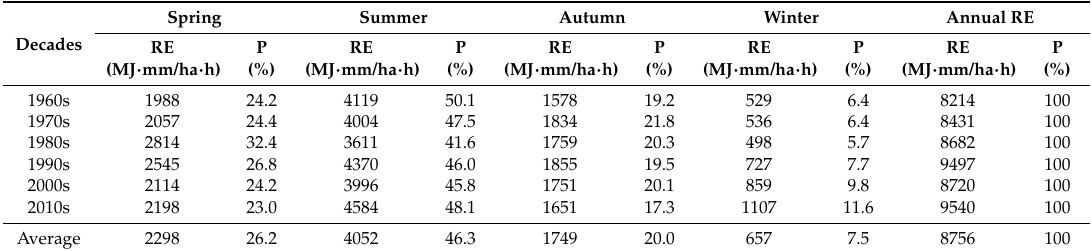
Table 1. Seasonal distribution of rainfall erosivity and its percentage in different decades.